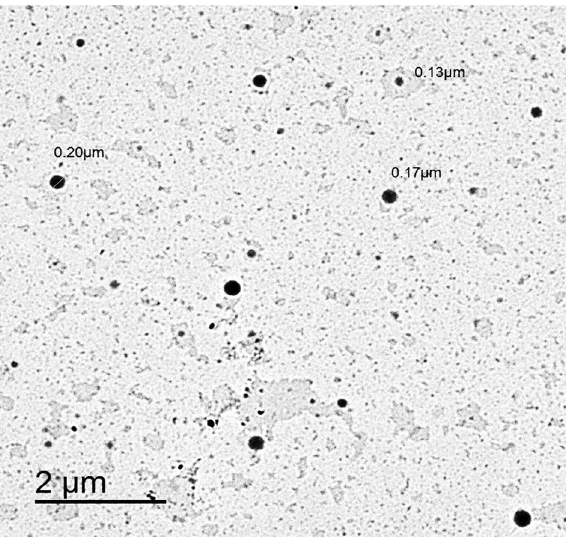
Figure 2. The image of synthesized alpha lipoic acid nanoparticles loaded liposomes (ALAN) characterized by transmission electron microscope (type JEOL-JEM